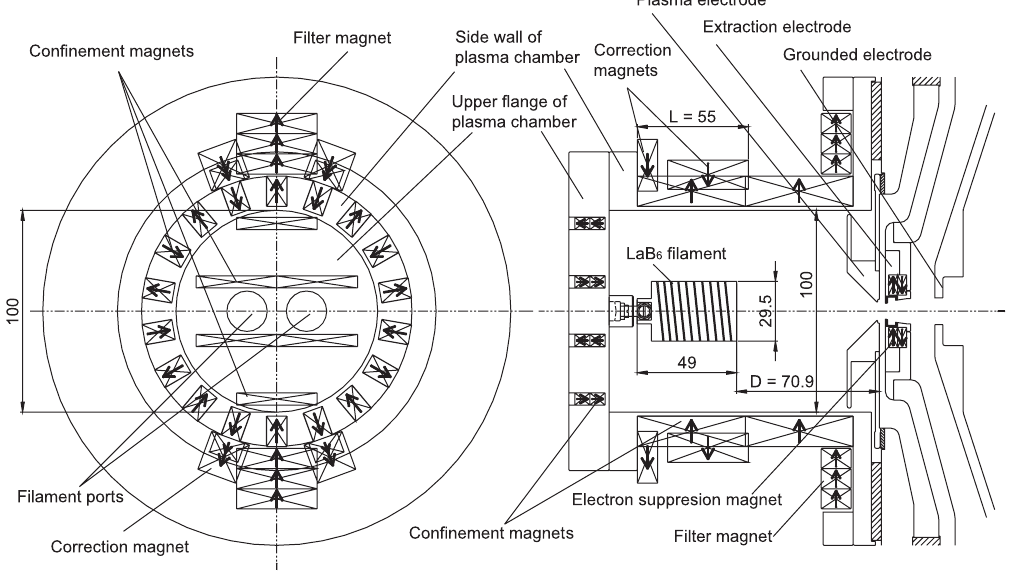
FIG. 3. Detailed layout of ion source plasma chamber.